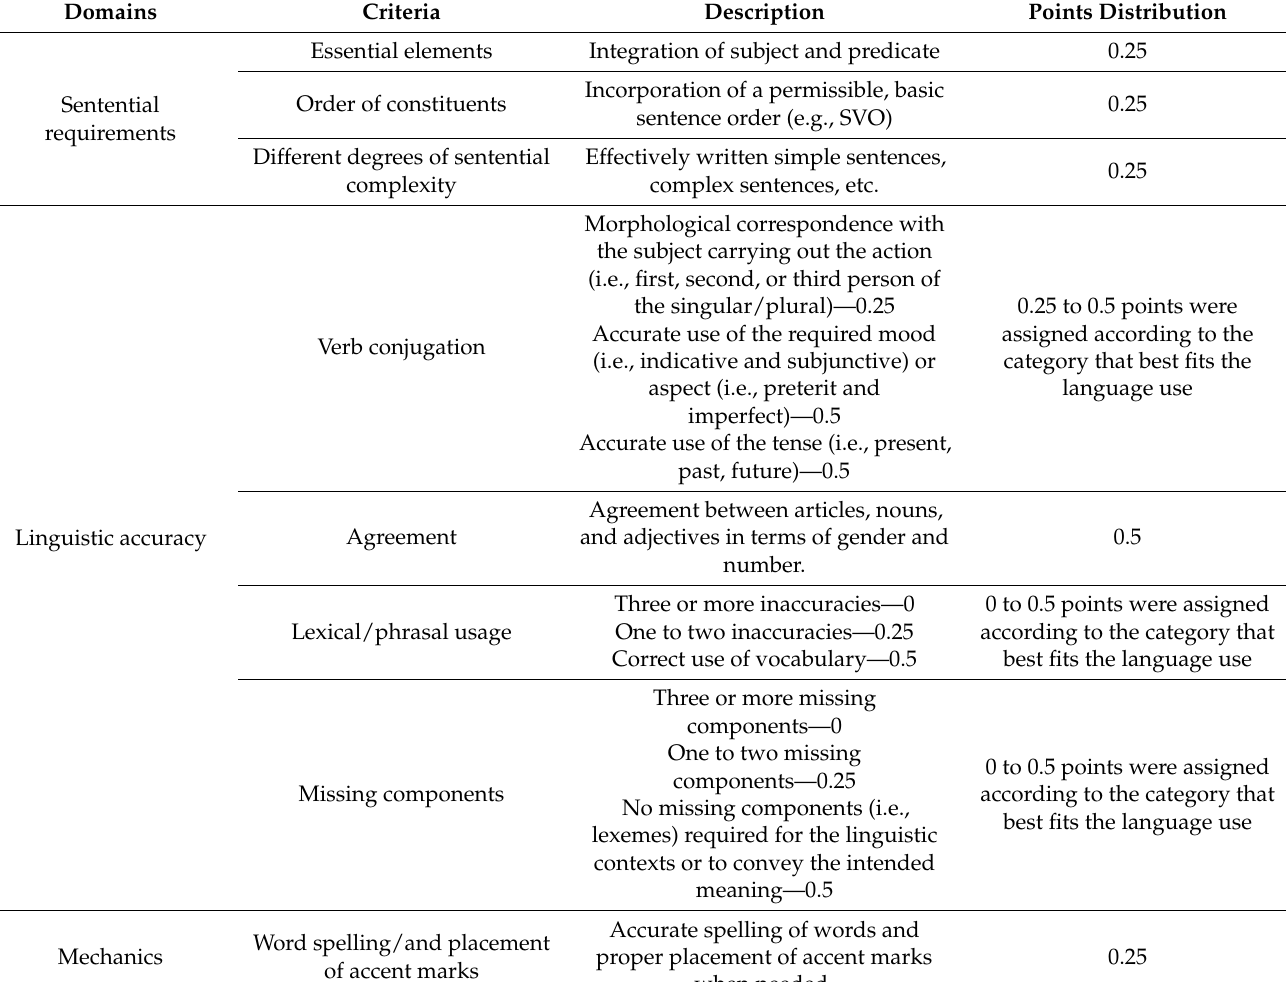
Table 3. Rating rubric for composition